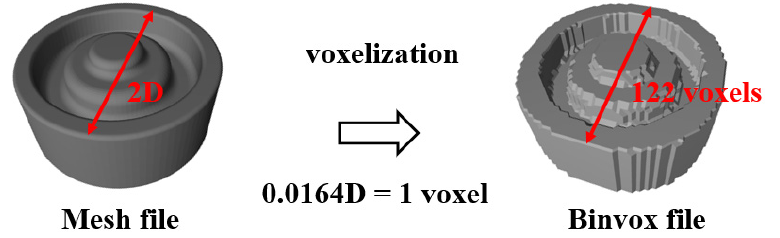
Figure A1. Pre-processing procedure to voxel grid-scale.